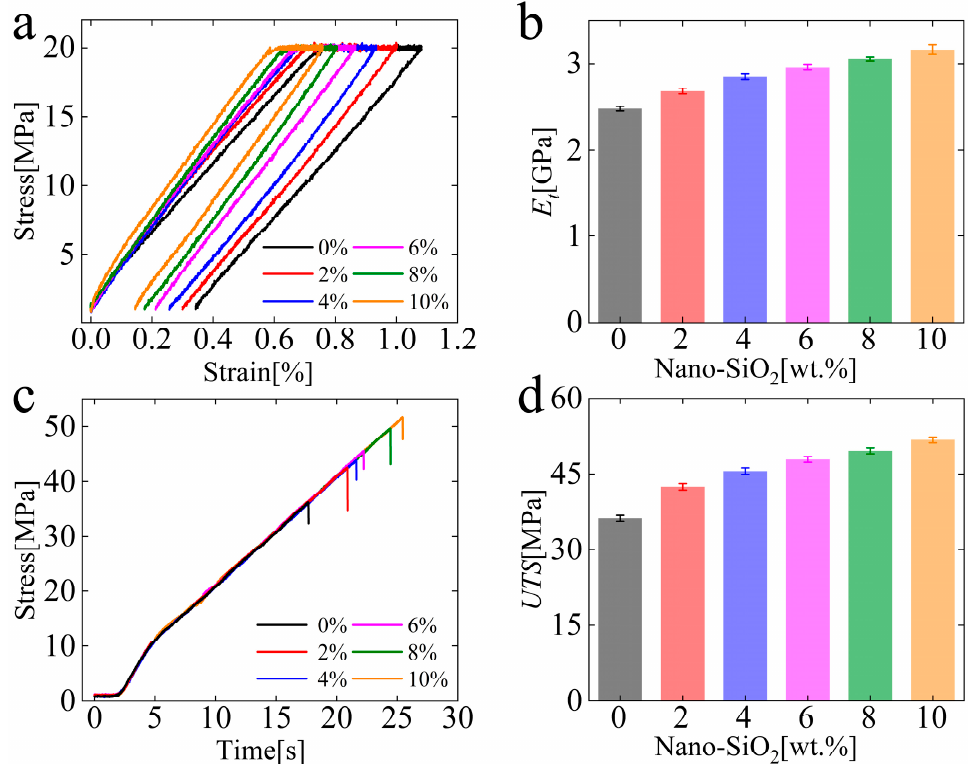
Figure 4. Results of the macroscale tensile test. ( a ) Stress-strain curves; ( b ) Stress-time curves; ( c ) Tensile modulus (Et); and ( d ) Ultimate tensile strength (UTS) of the composites with different nanoparticle contents.